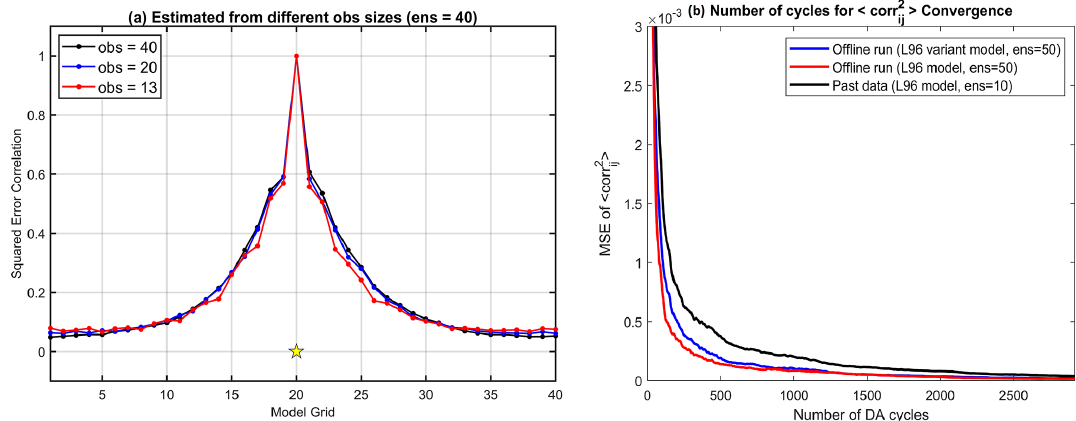
Figure 2. (a) The temporal mean squared error correlations estimated from different observation amounts. The yellow star represents the correlated observation location. (b) The MSE of Eq. (6) estimated by the past data with 10 ensembles (black) and by the ideal offline runs with the L96 model (red) and the L96 variant model (blue).